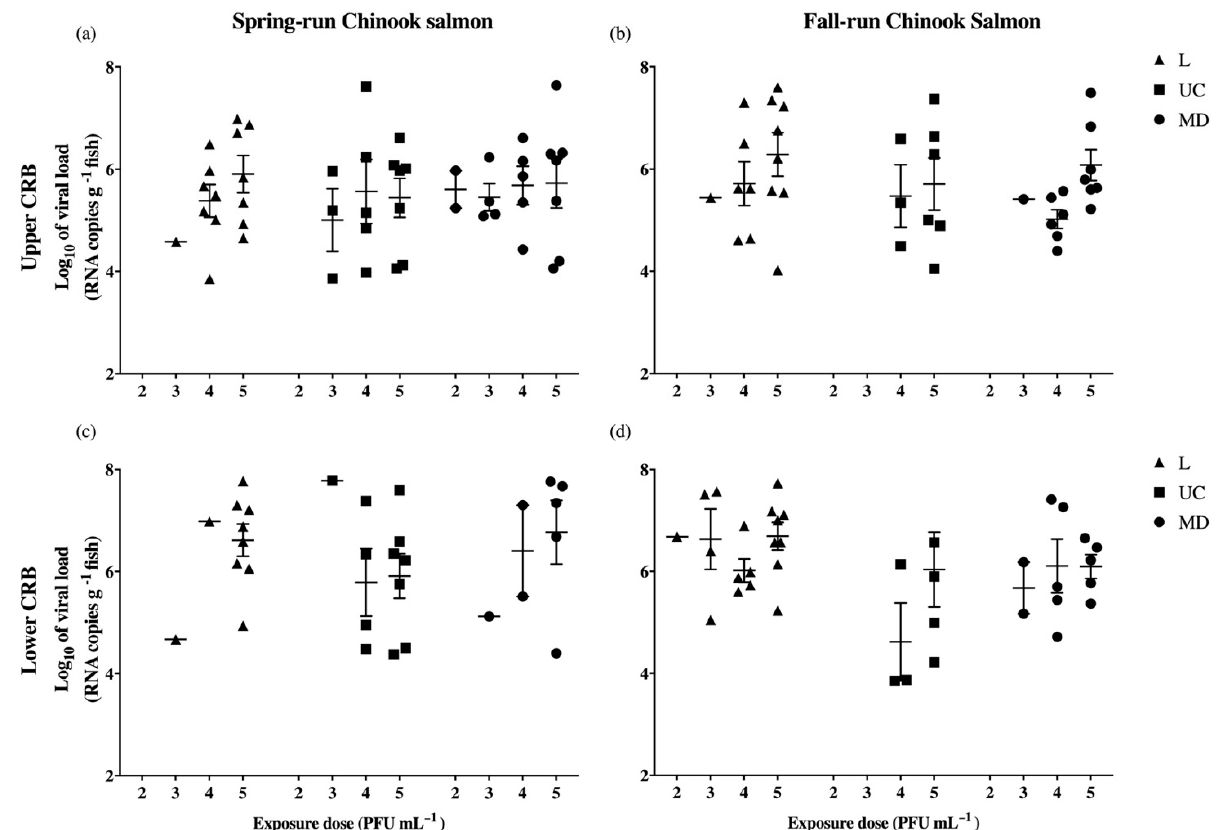
Figure 4. Viral load (log 10 RNA copies g − 1 of fish) of IHNV positive spring-( a , c ) and fall-run ( b , d ) Chinook salmon of the upper ( a , b ) and lower ( c , d ) Columbia River Basin at 3 days post exposure (dpe) to L, UC, or MD strains of IHNV. Exposure dosages are reported along x -axes as exponents of viral challenge concentrations (2 × 10 2 –2 × 10 5 PFU mL − 1 ). Mean log 10 viral loads ( ± SEM) are indicated for each group of virus positive fish. Quantities of IHN virus detected at 3 dpe are reported in Table